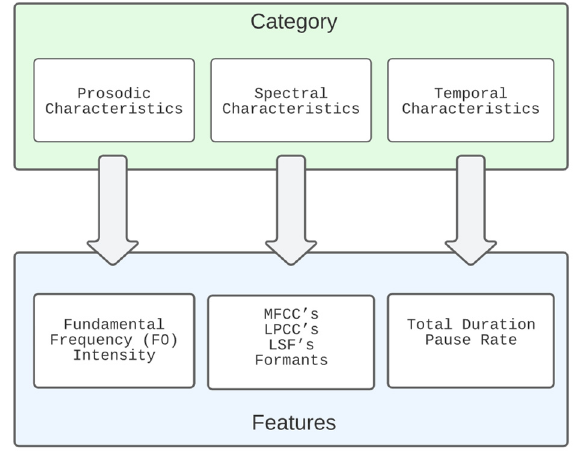
Figure 5. Features commonly used for detecting emotional state.